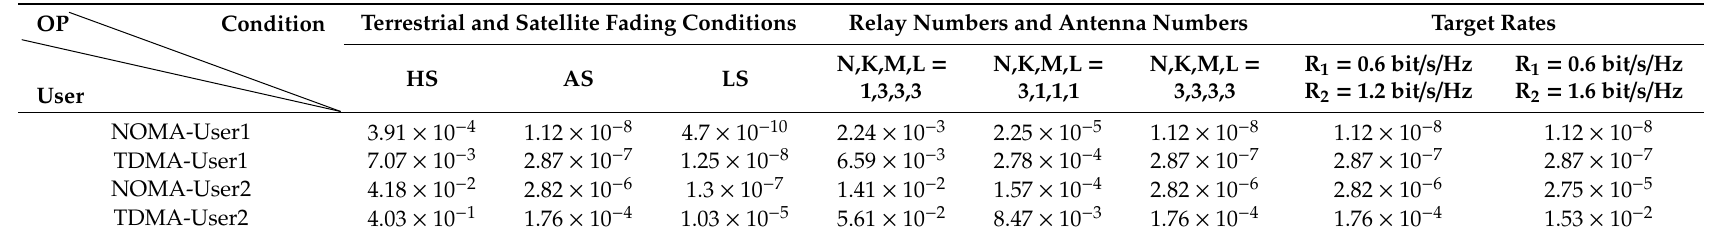
Table 1. Outage probability vs. various